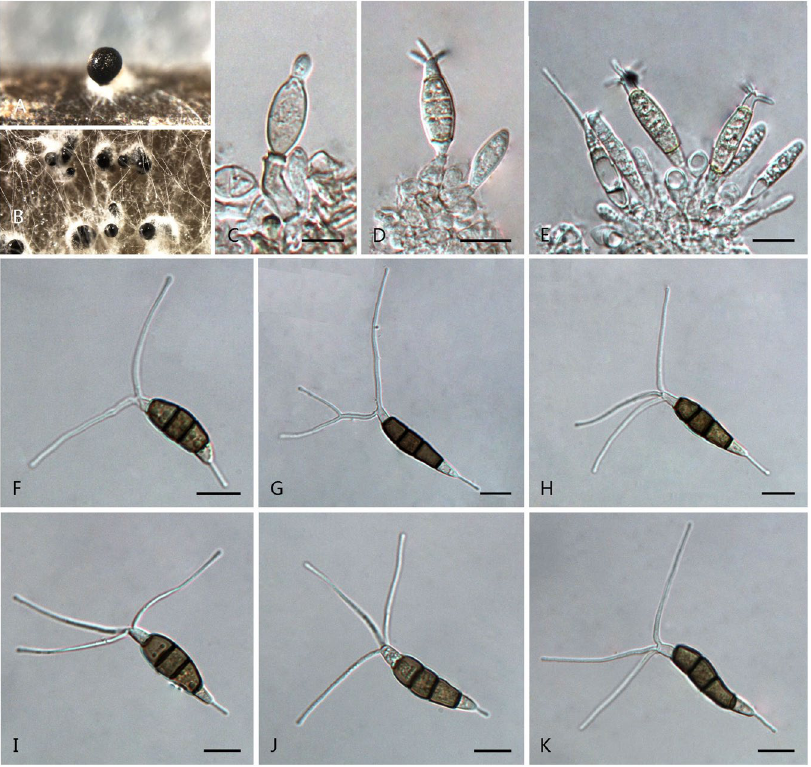
Figure 11. Pestalotiopsis longiappendiculata (from ex-holotype culture CGMCC 3.18153 ( = LC3013)). ( A ) Conidioma sporulating on pine needle. ( B ) Conidiomata sporulating on PDA. ( C–E ) Conidiogenous cells and conidia. ( F–K ) Conidia. Scale bars = 10 μ